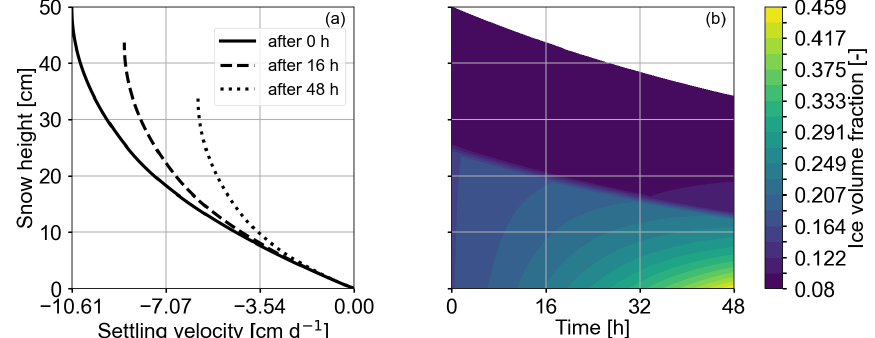
Figure 4. Plots show the results of Case 1 of Table 2, corresponding to isolated settling effects. Panel (a) depicts vertical velocity over snow height. The profiles show the state of the snowpack at initiation, after 16 and after 48h. It is clearly visible that vertical velocity and absolute snow height decrease with time. Panel (b) depicts the ice volume fraction over time. We interpret the lower, lighter part of the plot, where changes in the ice volume fraction are clearly discernible, as the lower layer and the darker, upper part of the plot as the upper layer. Changes in ice volume fraction are visible in the lower layer; it increases the most at the bottom of the snowpack.